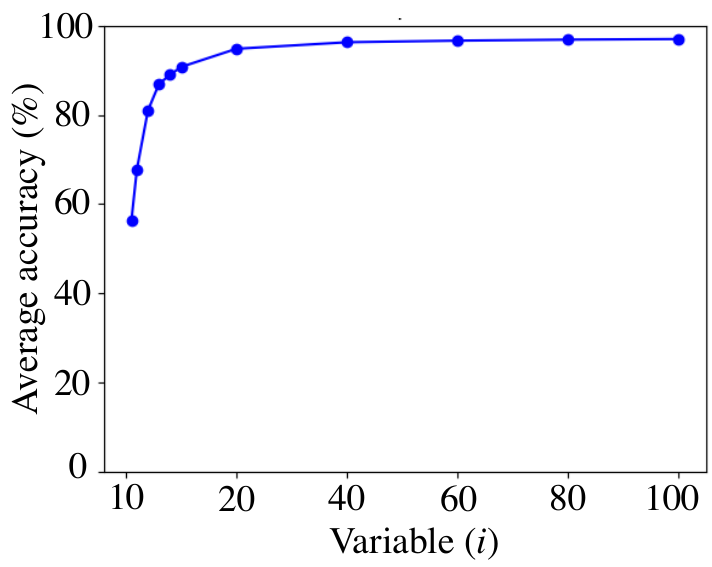
Figure 14. Learning curve of scenario RF-GAN for i = 1, 2, 4, 6, 8, 10, 20, 60, 80, and 100% of the training set.